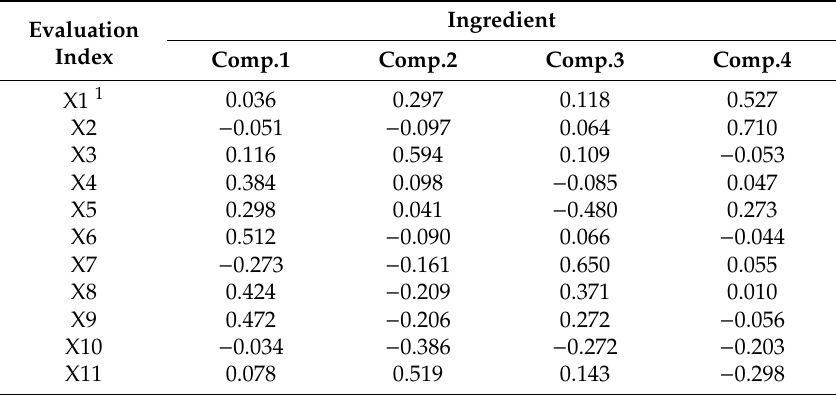
Table 5. Score coe ffi cient matrix of principal component